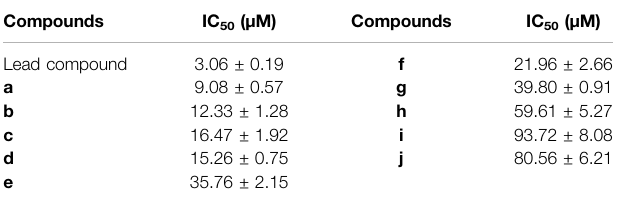
TABLE 4 | Inhibitory activity of each compound at the cellular level. Compounds IC 50 ( μ M) Lead